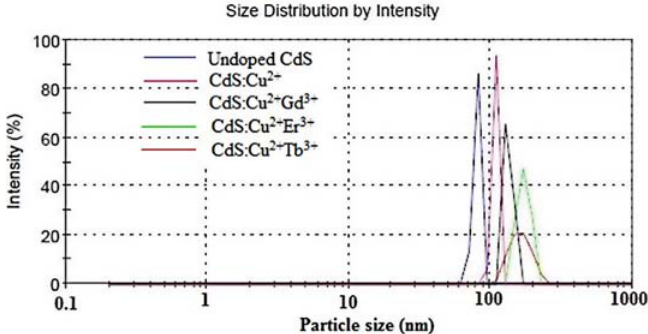
Figure 5. Particle size by DLS technique for (a) undoped CdS (b) CdS:Cu 2+ (c) CdS:Cu 2+ Gd 3+ (d) CdS:Cu 2+ Er 3+ (e) CdS:Cu 2+ Tb